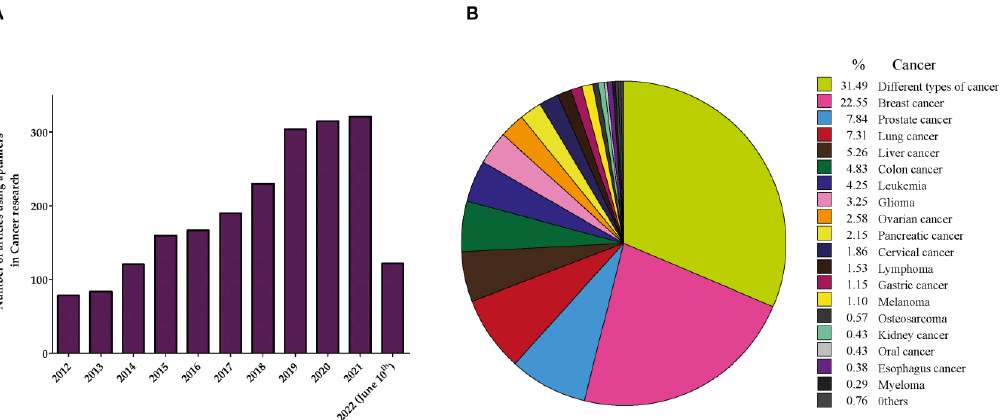
Figure 3. Aptamers in cancer research. ( A ) Yearly trend of published articles reporting the application of aptamers in cancer research. ( B ) Proportion of types of cancer in which aptamers are most frequently used for therapeutic or diagnostic purposes.